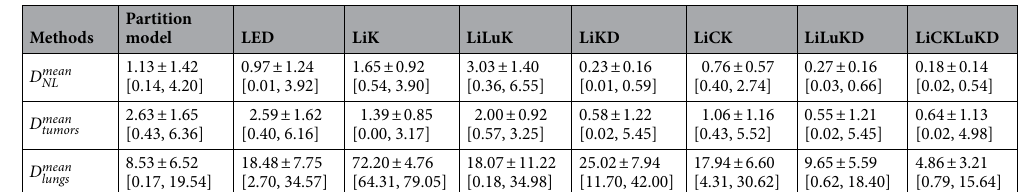
mean in VOIs using partition model and VSV methods compared